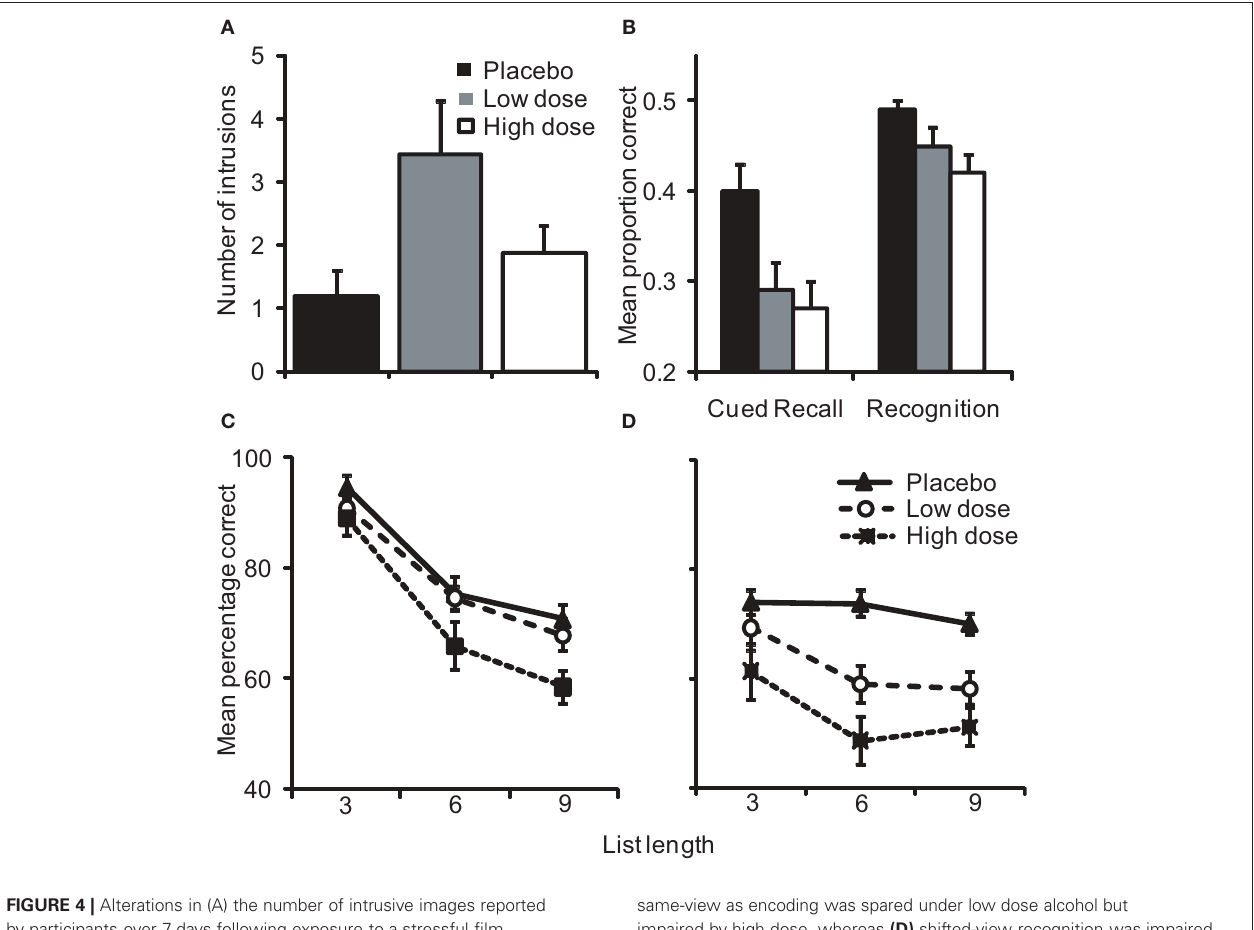
FIGURE 4 | Alterations in (A) the number of intrusive images reported by participants over 7 days following exposure to a stressful film and (B) explicit memory for the footage on day 8 as a function of alcohol dose. Object location recognition tested from the (C)